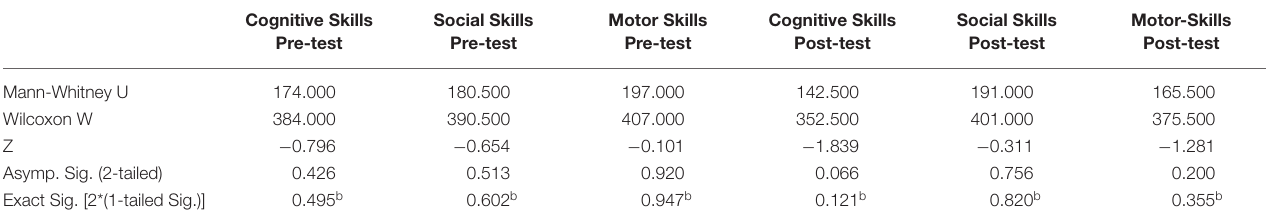
TABLE 3 | Mann-Whitney U Test Computed with Pre-post-tests from both Groups.